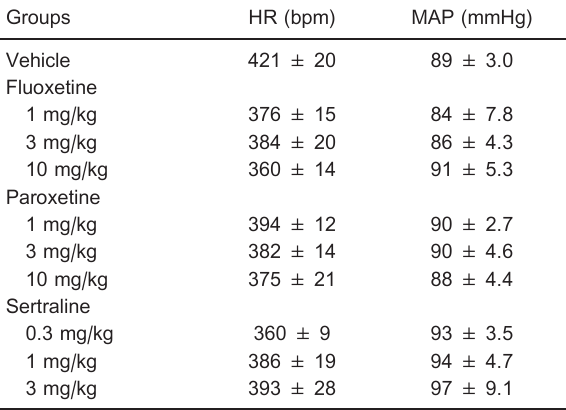
Table 1. Baseline values for heart rate (HR) and mean arterial pressure (MAP) of anesthetized Wistar rats in each experimental group (n=7 per group).